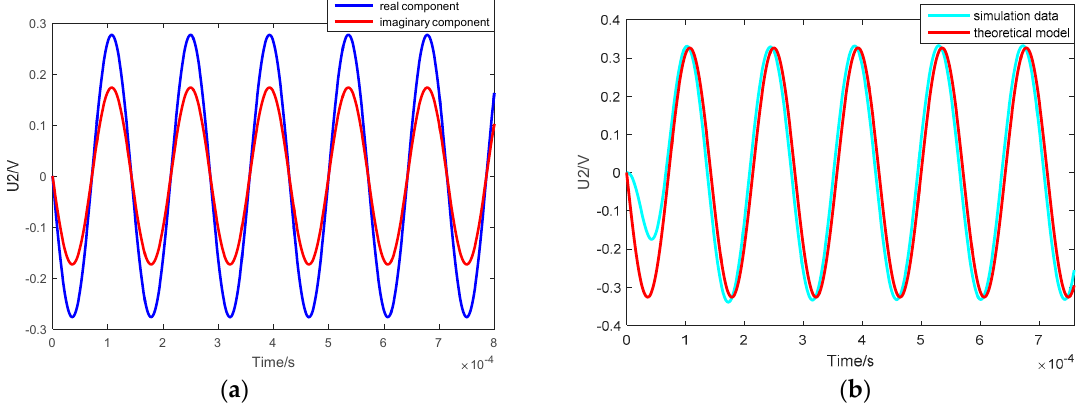
Figure 5. ( a ) The real component and imaginary component of the theoretical model; ( b ) contrast of the curves of output voltage for the simulated and theoretical models.